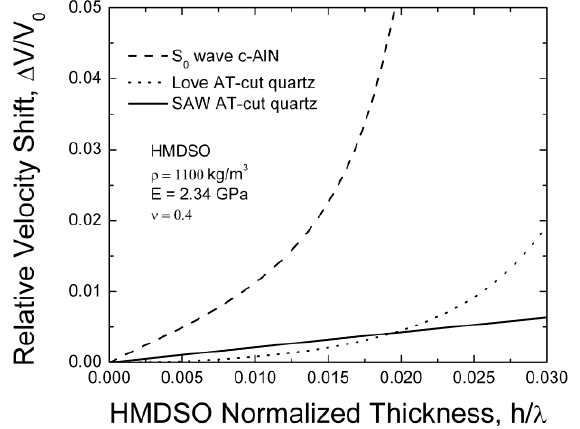
Figure 3. Theoretical mass sensitivity of RSAW, Love wave and S0 wave.